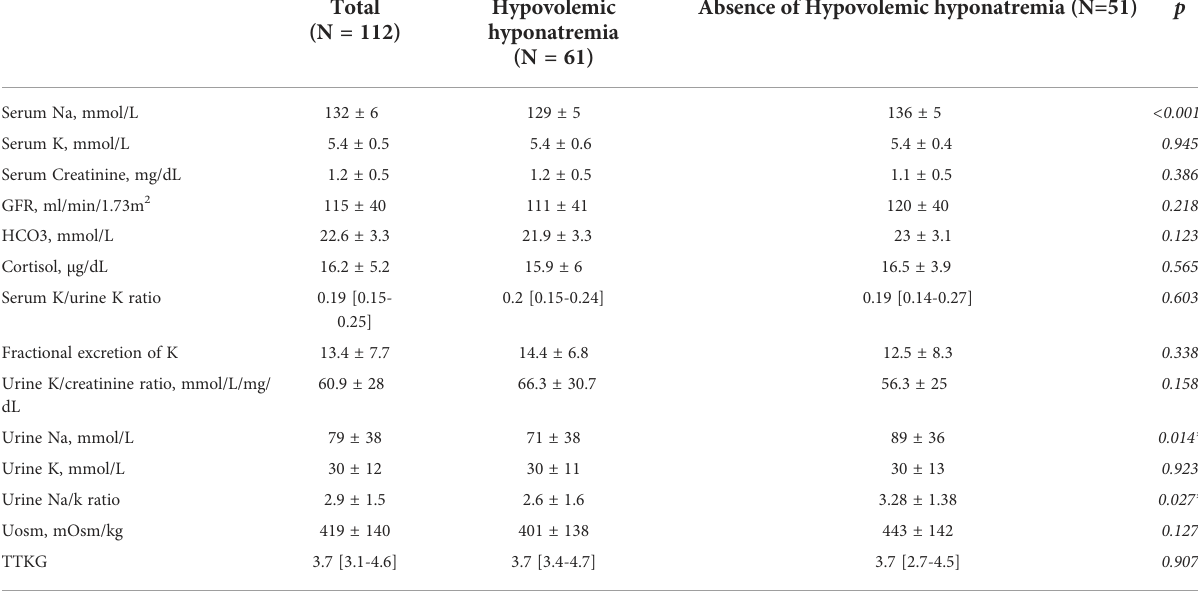
TABLE 3 Biochemical parameters at diagnosis in all cases compared according to the presence or absence of hypovolemic